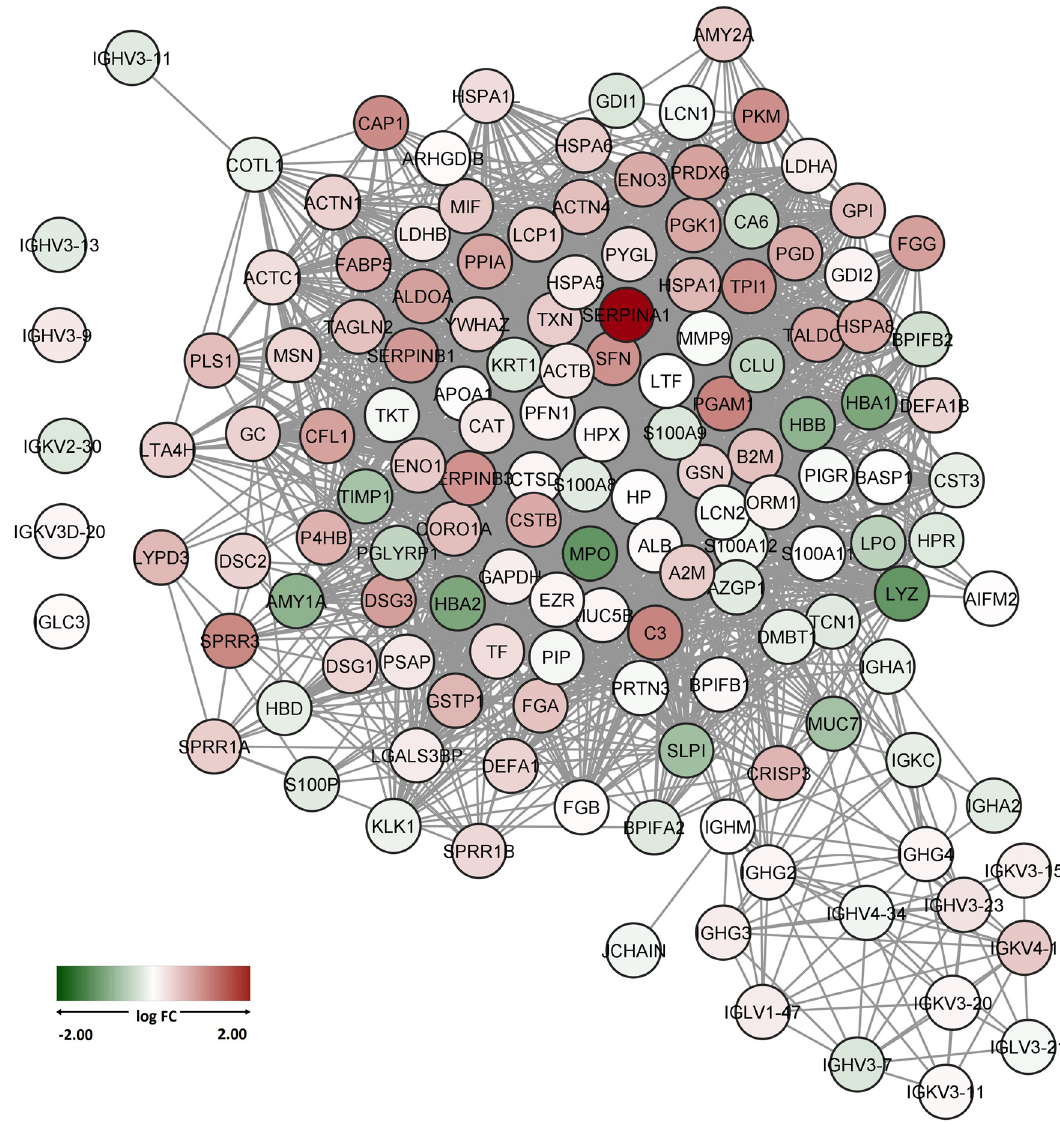
Figure 3: Identi fi cation of DEGs and construction of the TMD - related PPI. According to the node fi ll color mapping, the red color denotes the upregulated genes, and the green color stands for the downregulated genes; edges represented by lines are gray. The color intensity corresponds to the fold - change.